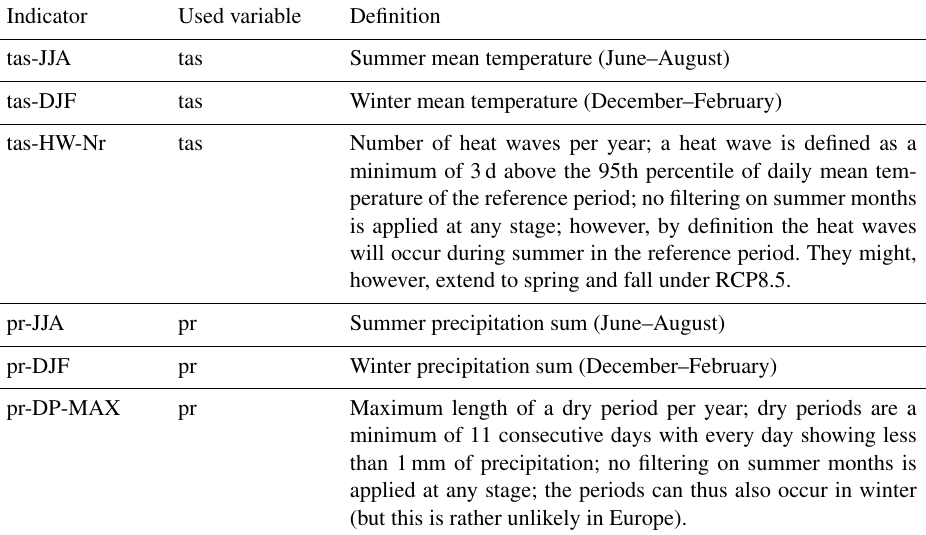
Table 1. Indicators and their definitions. Indicator Used variable